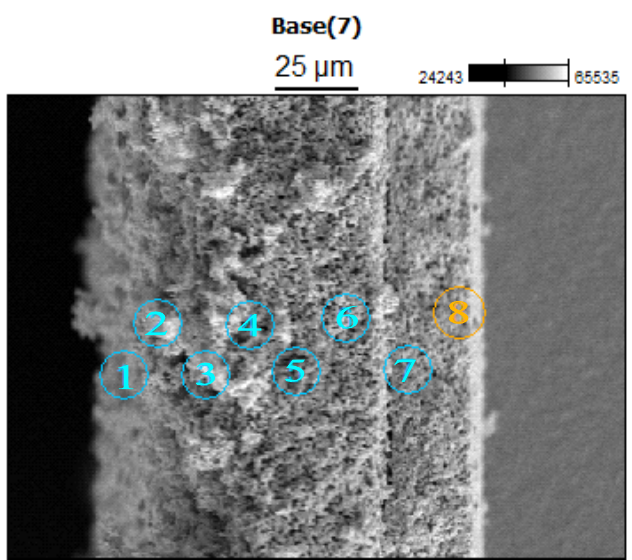
Figure 6. Cross-sectional SEM image of the cathode showing the points at which X-ray diffraction was performed to analyse the components